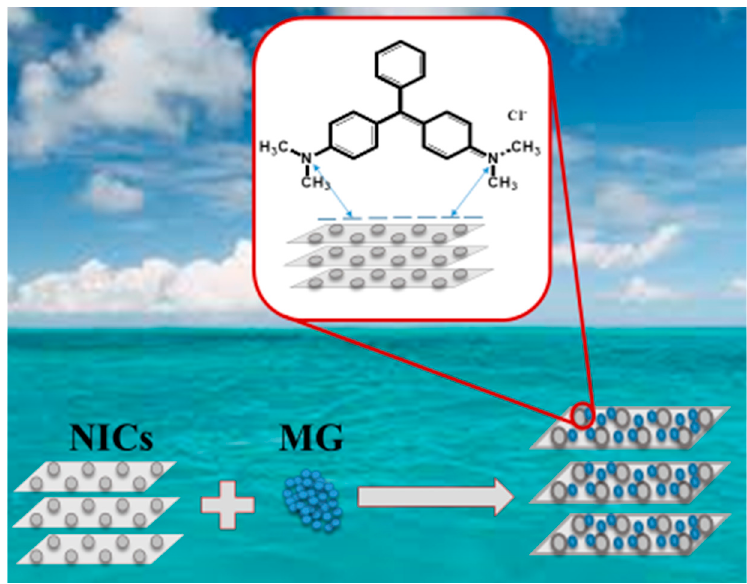
Figure 12. The adsorption mechanism of MG onto NICs.